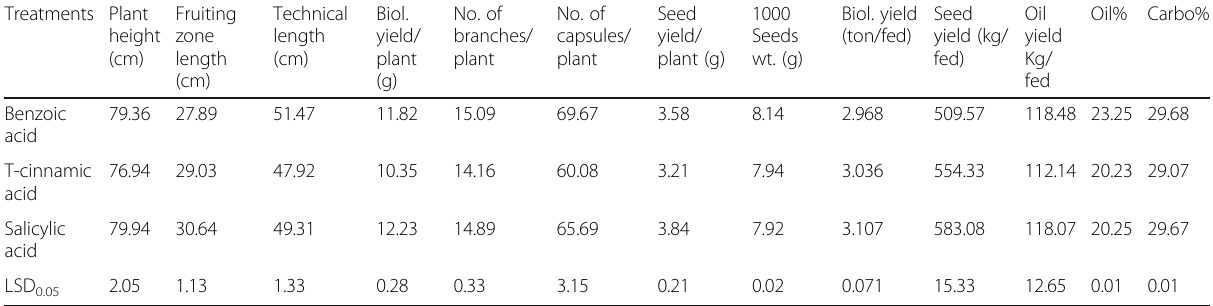
Table 7 Effect phenolic acid treatments on seed yield, its components, and oil and carbohydrate percentages of flax plants grown under sandy soil conditions (data are means of two successive seasons) Treatments Plant height